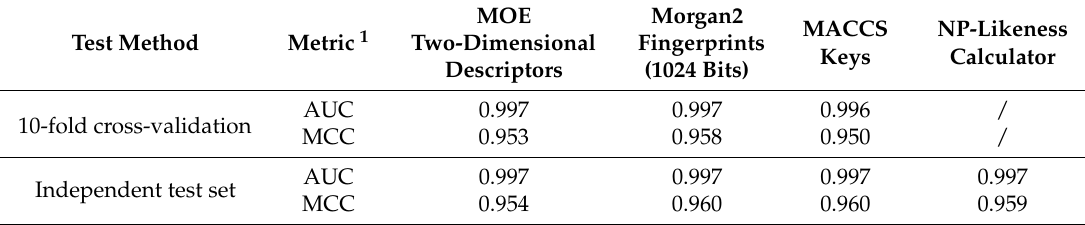
Table 2. Performance of models derived from different descriptors or